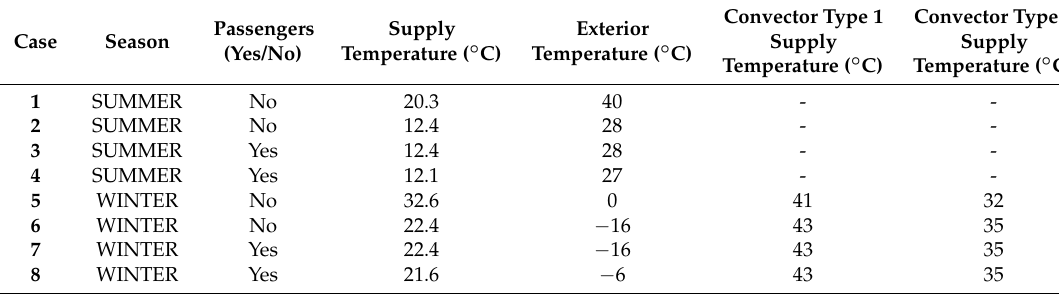
Table 2. Temperature working